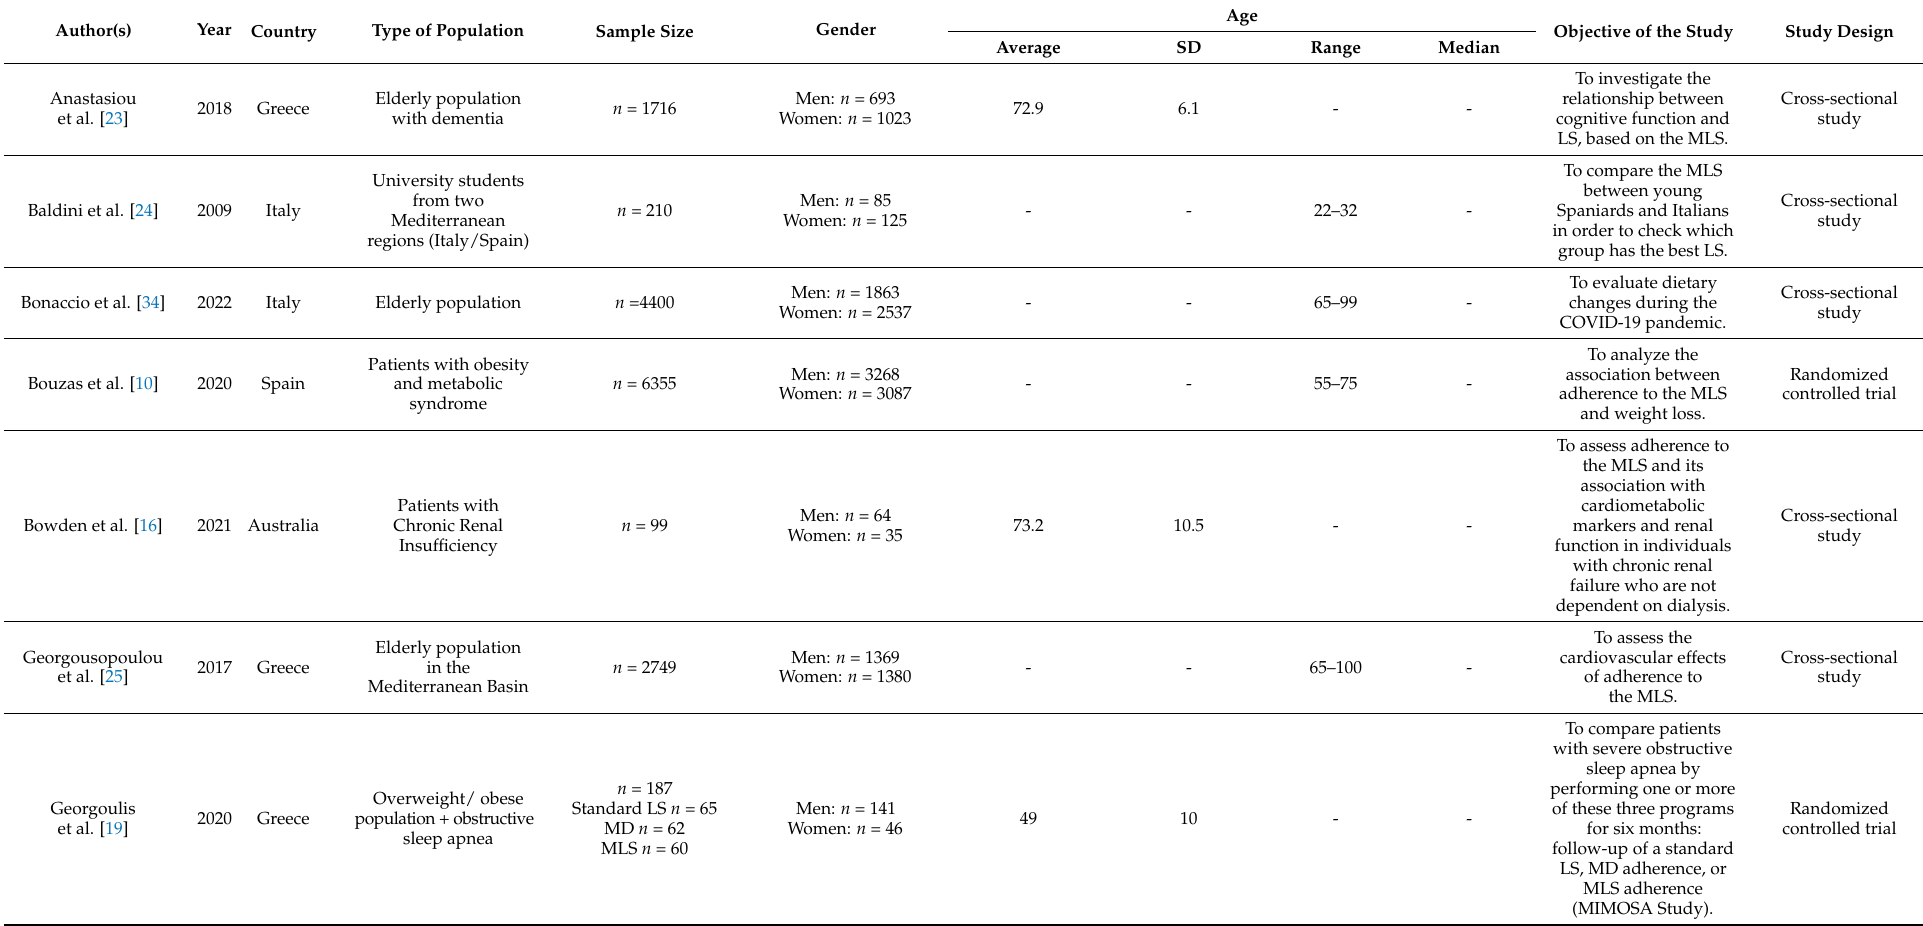
Table 3. General characteristics of the studies included in the